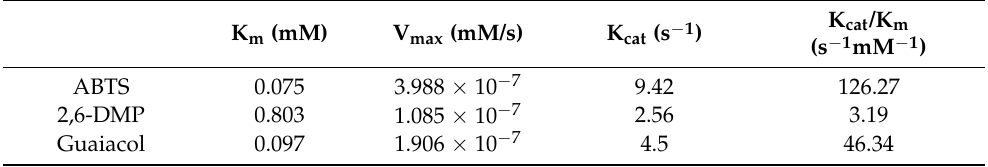
Table 1. The kinetic parameters of purified LAC-4